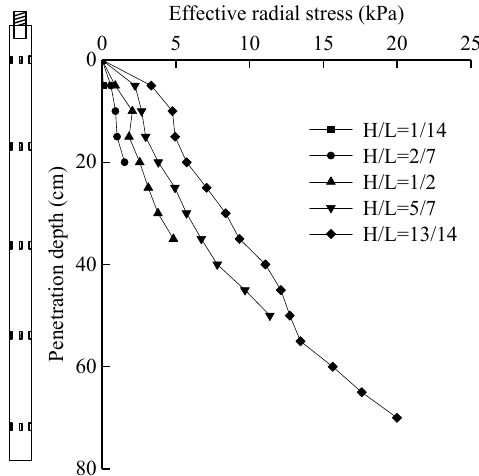
Figure 17. Relationship curve between effective radial stress and penetration depth. Table 6. Ratio of effective radial stress to total radial stress of model pile at different depths. Depth of Sensor (cm)